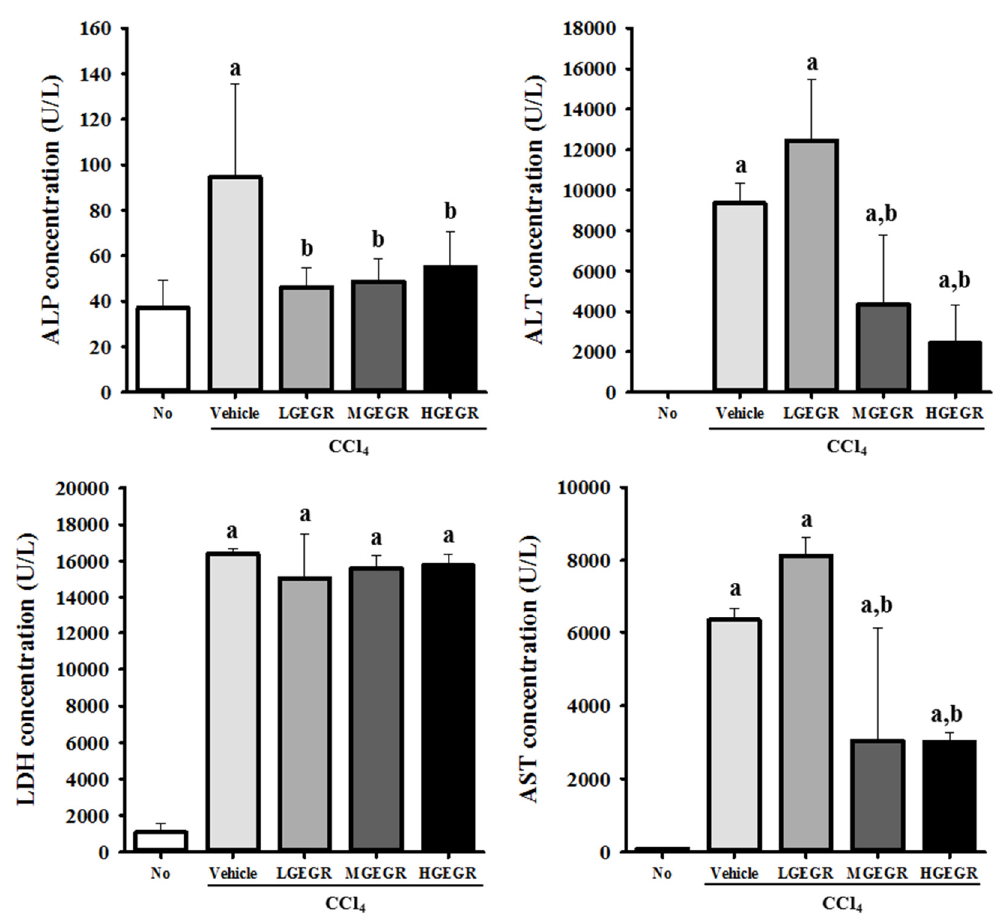
Figure 2. Biochemical markers of hepatic toxicity. Blood was collected from the abdominal veins of vehicle/CCl 4 and three GEGR/CCl 4 treated ICR mice (no treatment and HGEGR group ( n = 7), LGEGR group ( n = 6), vehicle and MGEGR group ( n = 8)). Serum concentrations of ALP, AST, ALT, and LDH were analyzed in duplicate using a serum biochemical analyzer as described in the Materials and Methods. Data represent the means ± SD of three replicates. a, p < 0.05 relative to the no treatment group; b, p < 0.05 relative to the vehicle/CCl 4 treated group.